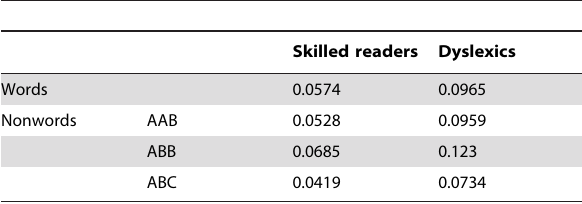
Table 2. Accuracy (proportion errors) of skilled and dyslexic participants in word/nonword discrimination (Experiment